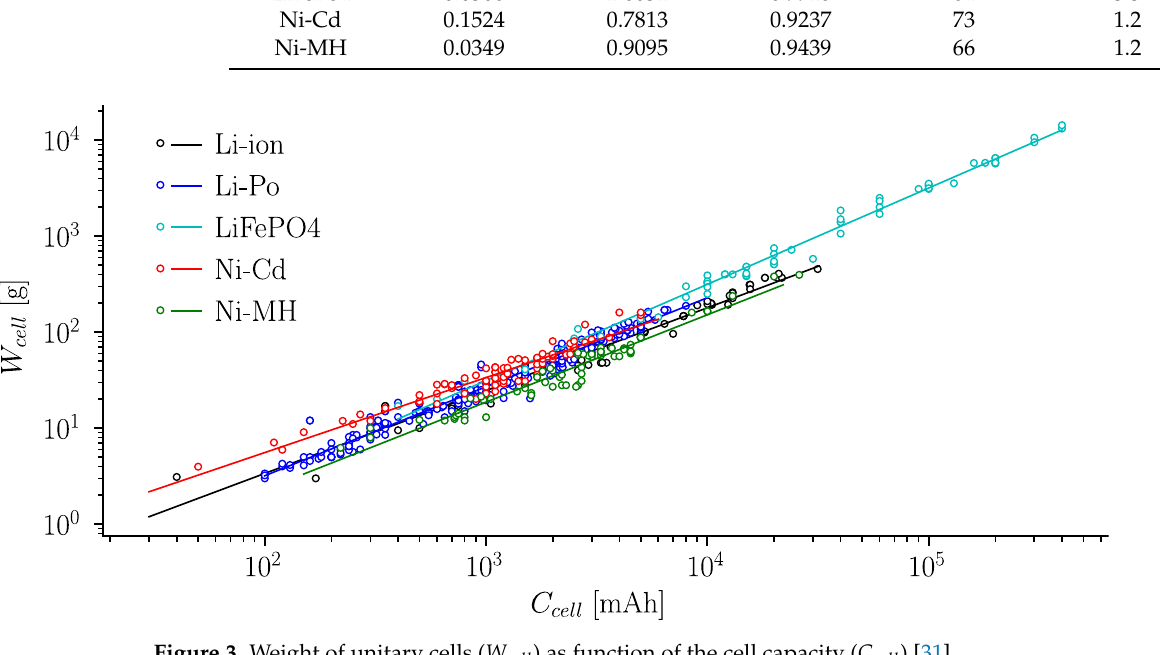
Figure 3. Weight of unitary cells ( W cell ) as function of the cell capacity ( C cell ) [31].